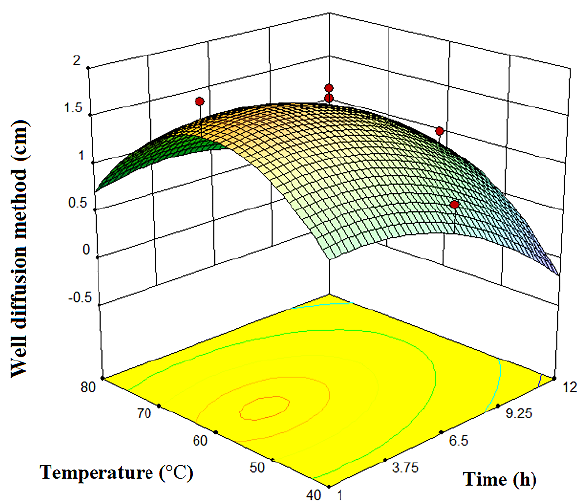
Figure 3. Response surface of the size of the well, as a function of time and temperature at the PP/S of 0.5.